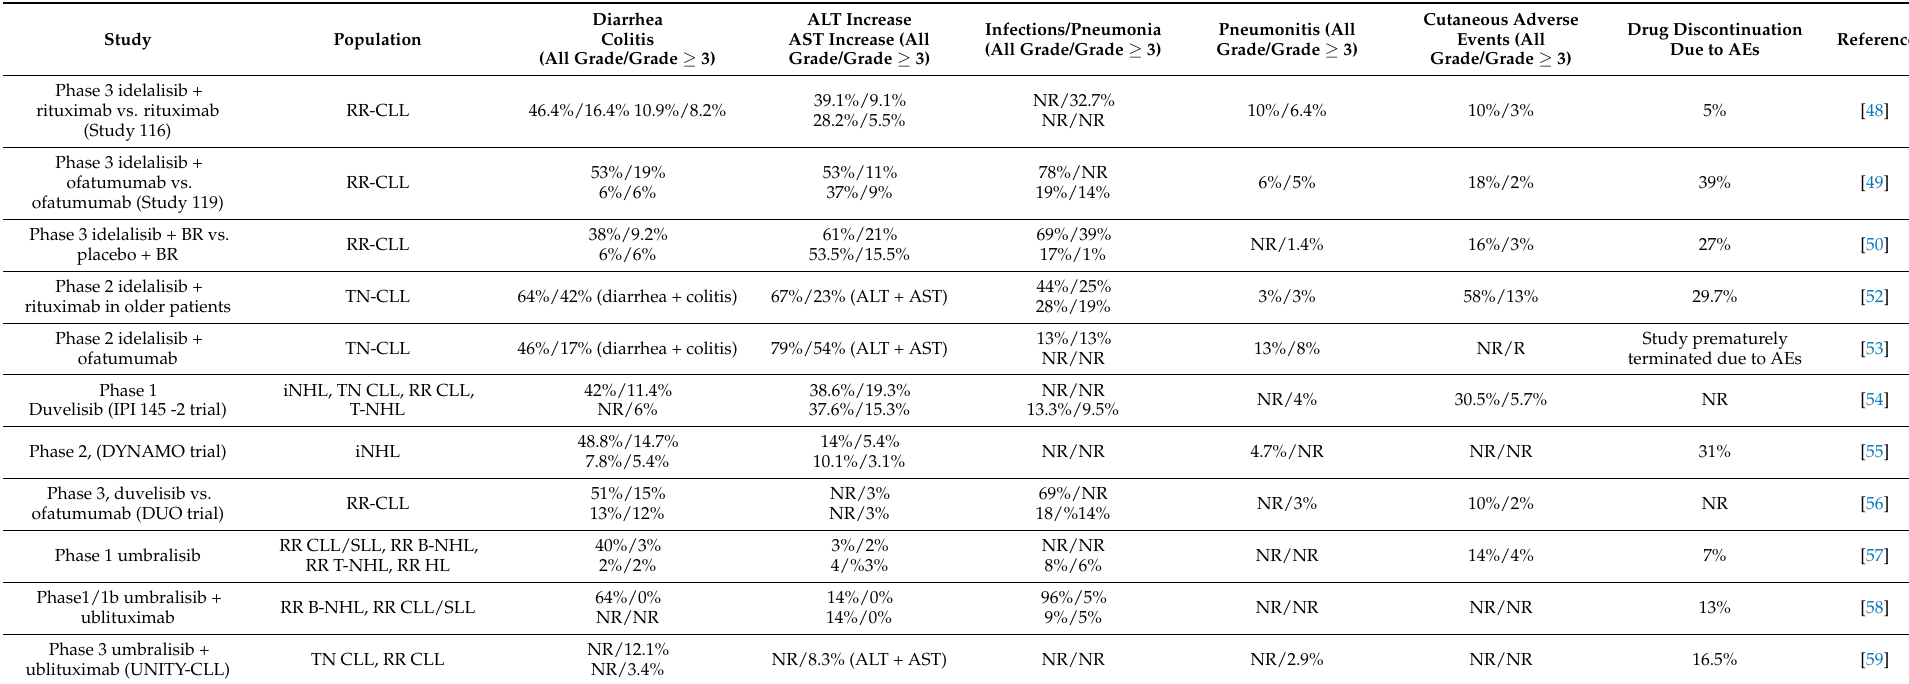
Table 3. Summary of non-hematological characteristic PI3Ki-related adverse events across selected